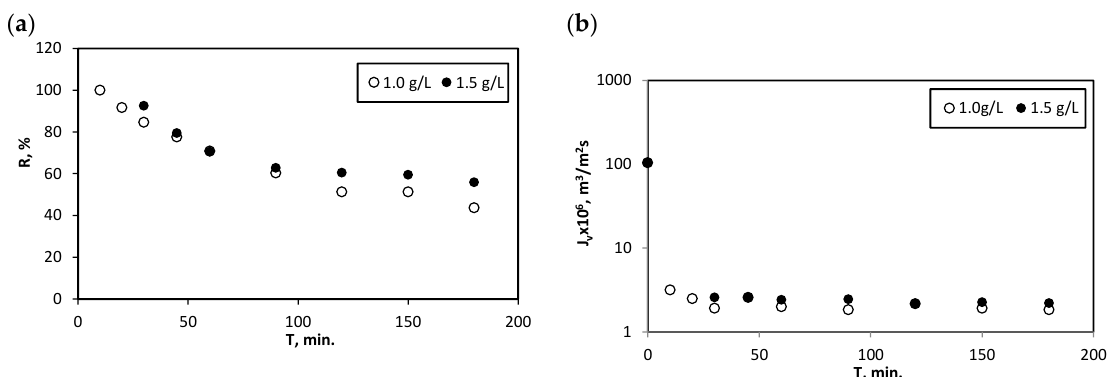
Figure 10. Changes in retention coefficient ( a ) and permeate flux ( b ) during sorption-assisted MF process in the case of experiments where the effect of increasing sorbent concentration was analysed; composite MOF-type sorbent; T cont. = 60 min.